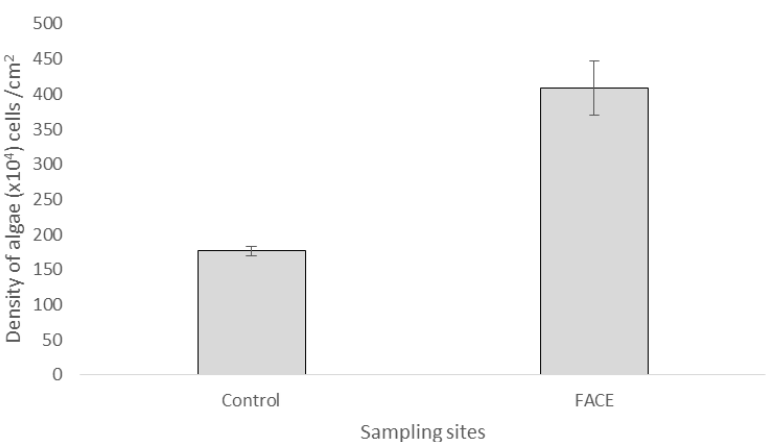
Figure 4. The density of Trebouxia sp. recorded from the control and FACE sampling sites after 380 days. Error bars represent standard error of means (SEM).